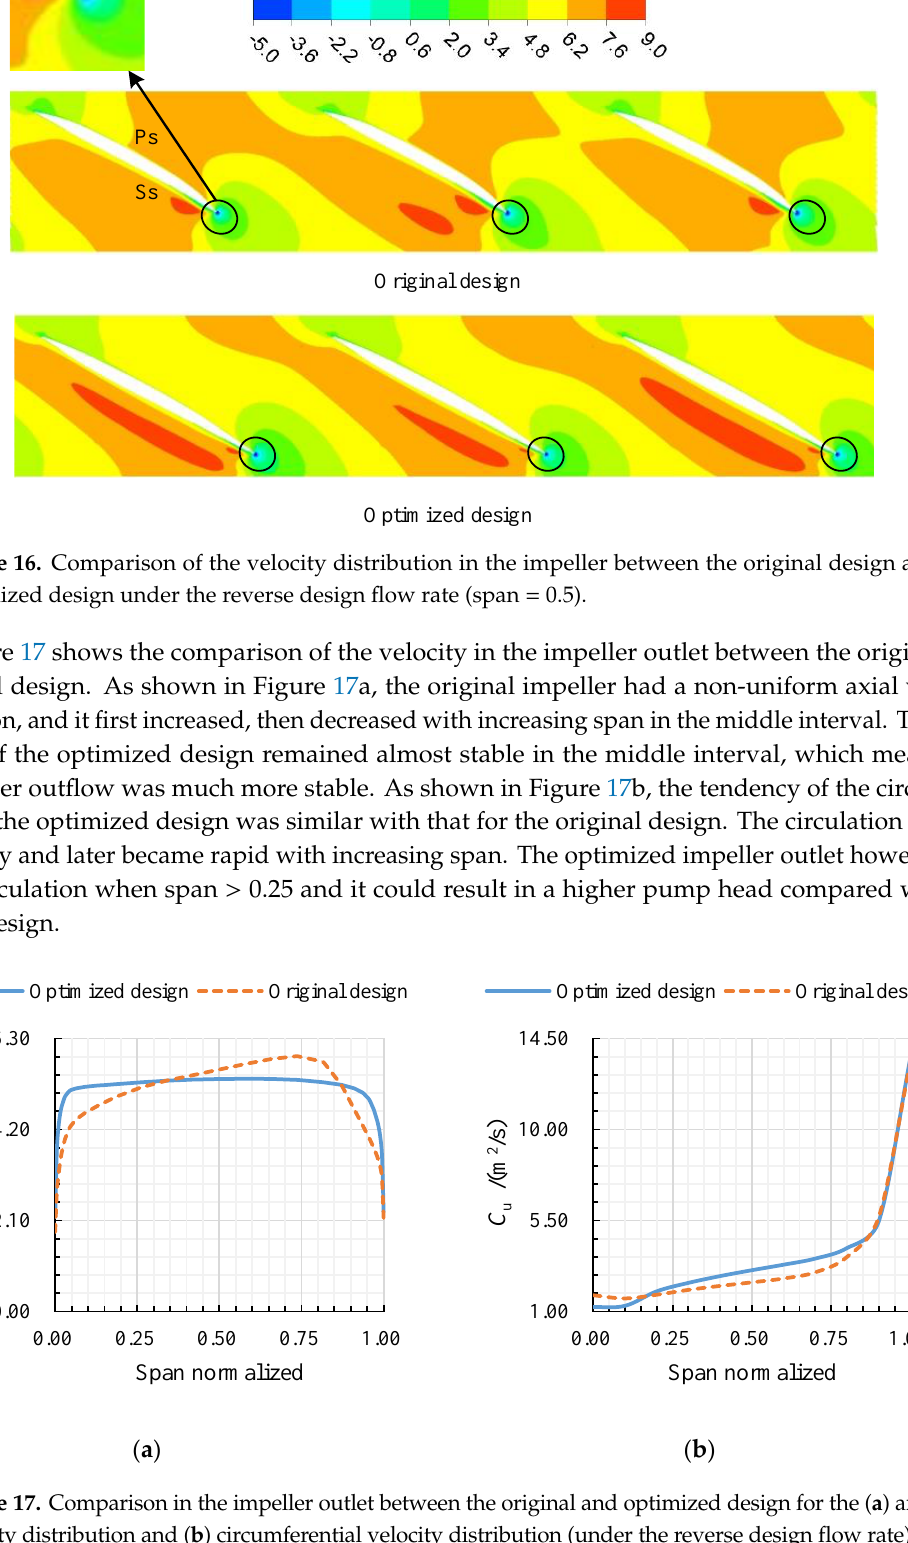
Figure 17. Comparison in the impeller outlet between the original and optimized design for the ( a ) axial velocity distribution and ( b ) circumferential velocity distribution (under the reverse design flow